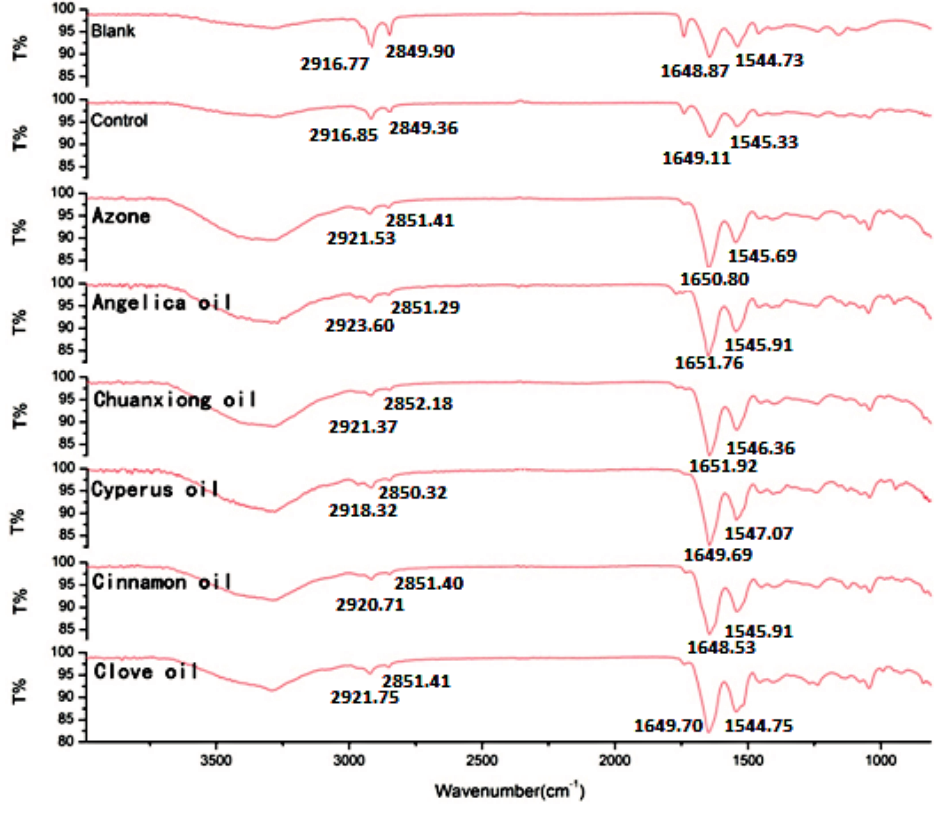
Figure 3. ATR-FTIR absorption spectra of rat skin treated with various PEs for 12 h. Note: the peak position values are the average of three